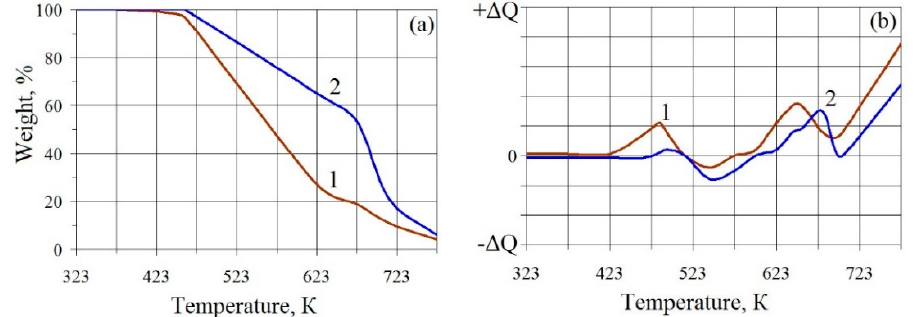
Figure 2. Thermogravimetric ( a ) and differential-thermal ( b ) analysis of (co)polymers: 1 – pHEMA/PVP mixture (pHEMA:PVP = 80:20 mass parts); 2 –pHEMA-gr-PVP copolymer (HEMA:PVP = 80:20 mass parts)